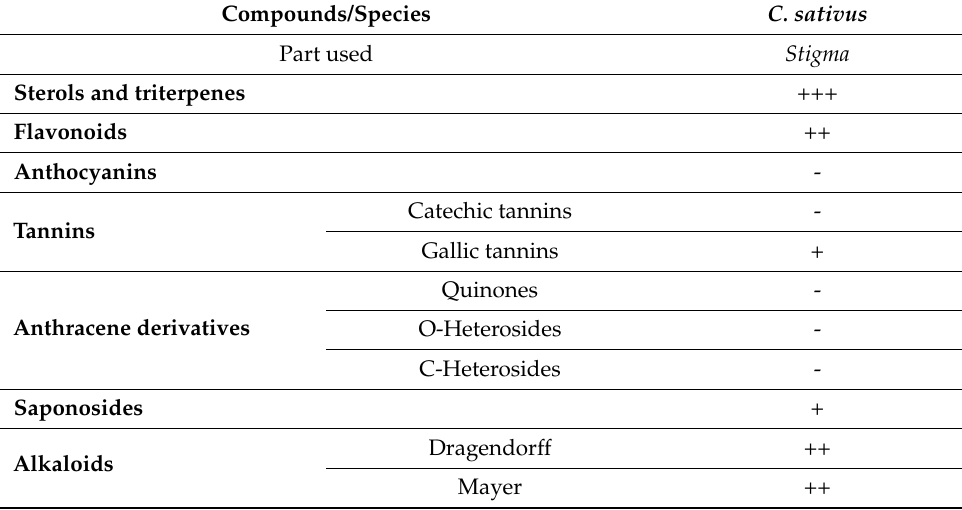
Table 3. Results of phytochemical tests.